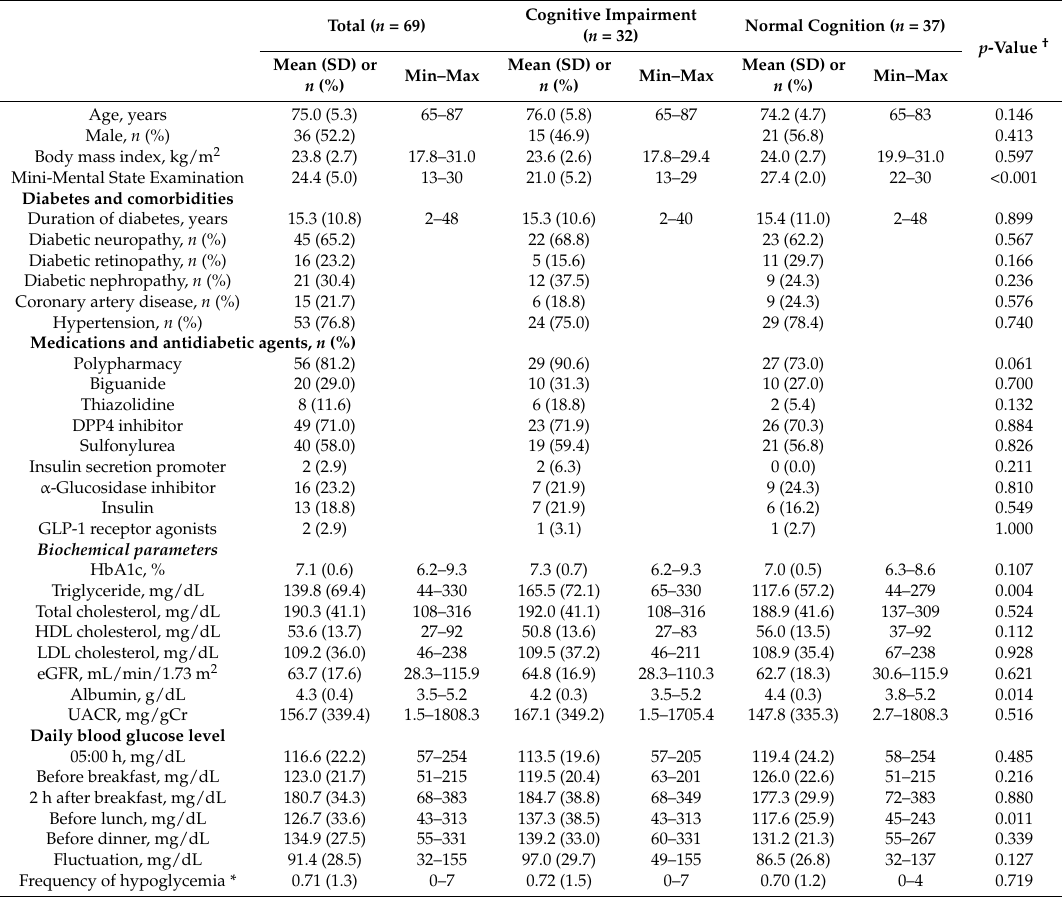
Table 1. Clinical characteristics of the study